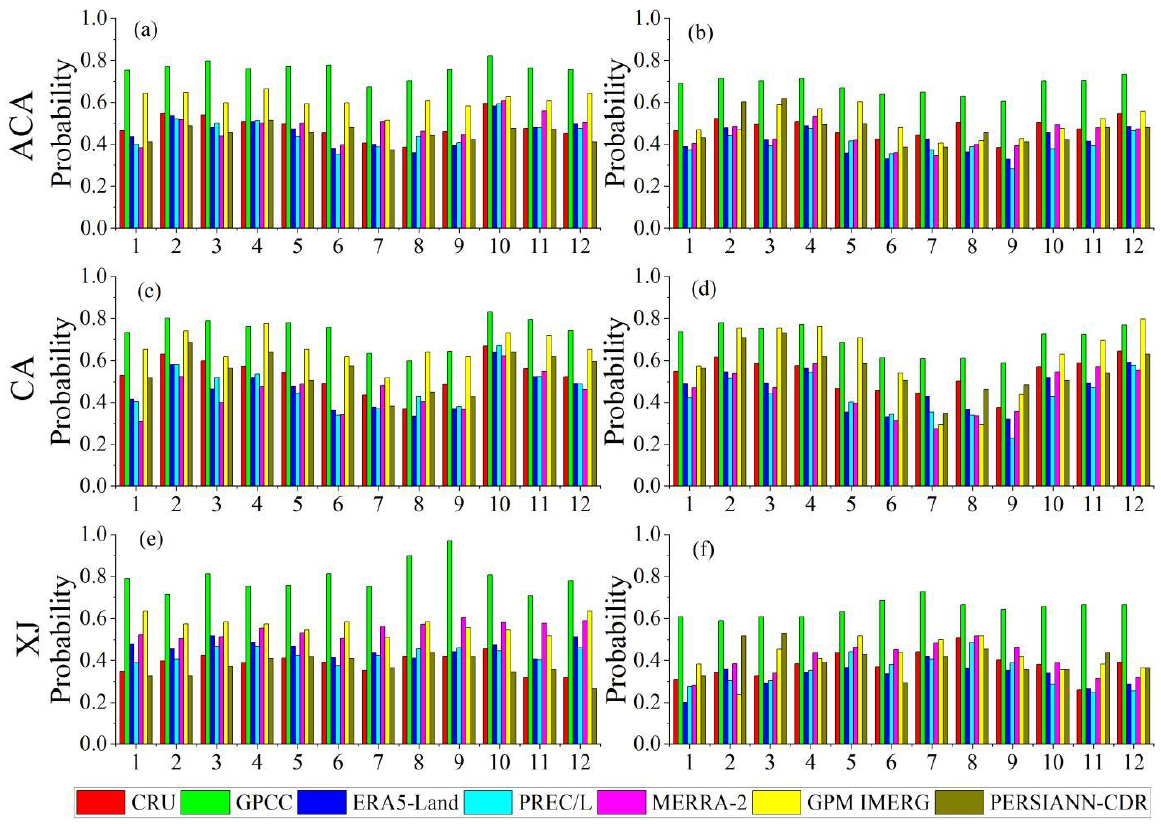
Figure 9. Monthly probability of heavy rainfall events ( a , c , e ) and drought events ( b , d , f ) captured by the seven products.